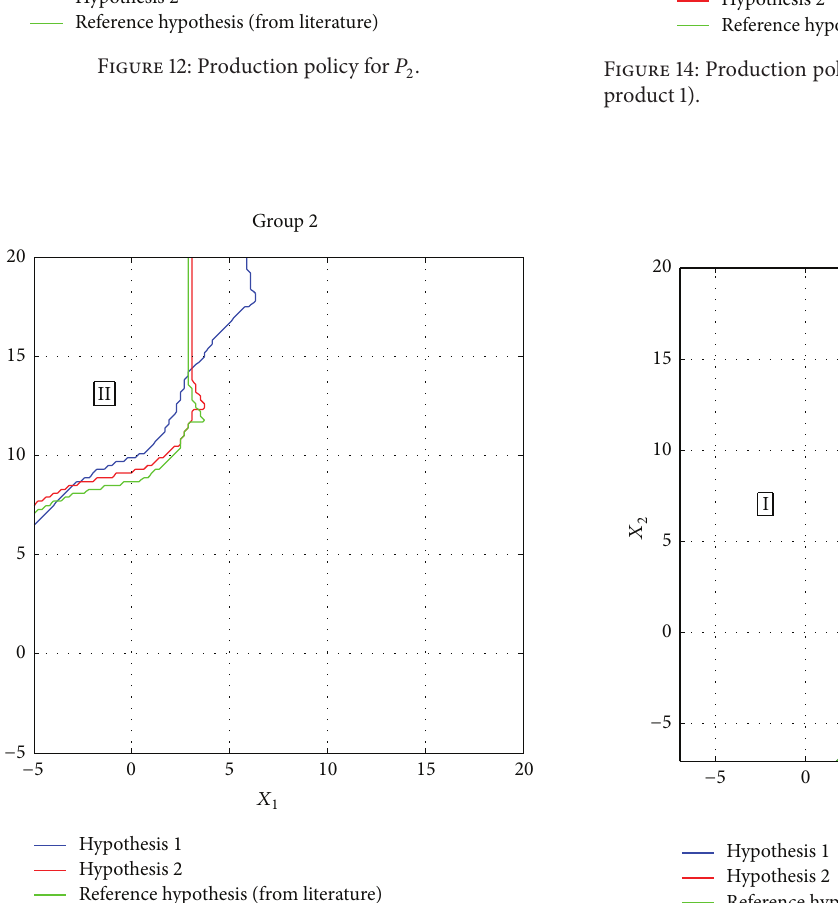
Figure 12: Production policy for 𝑃 2 .